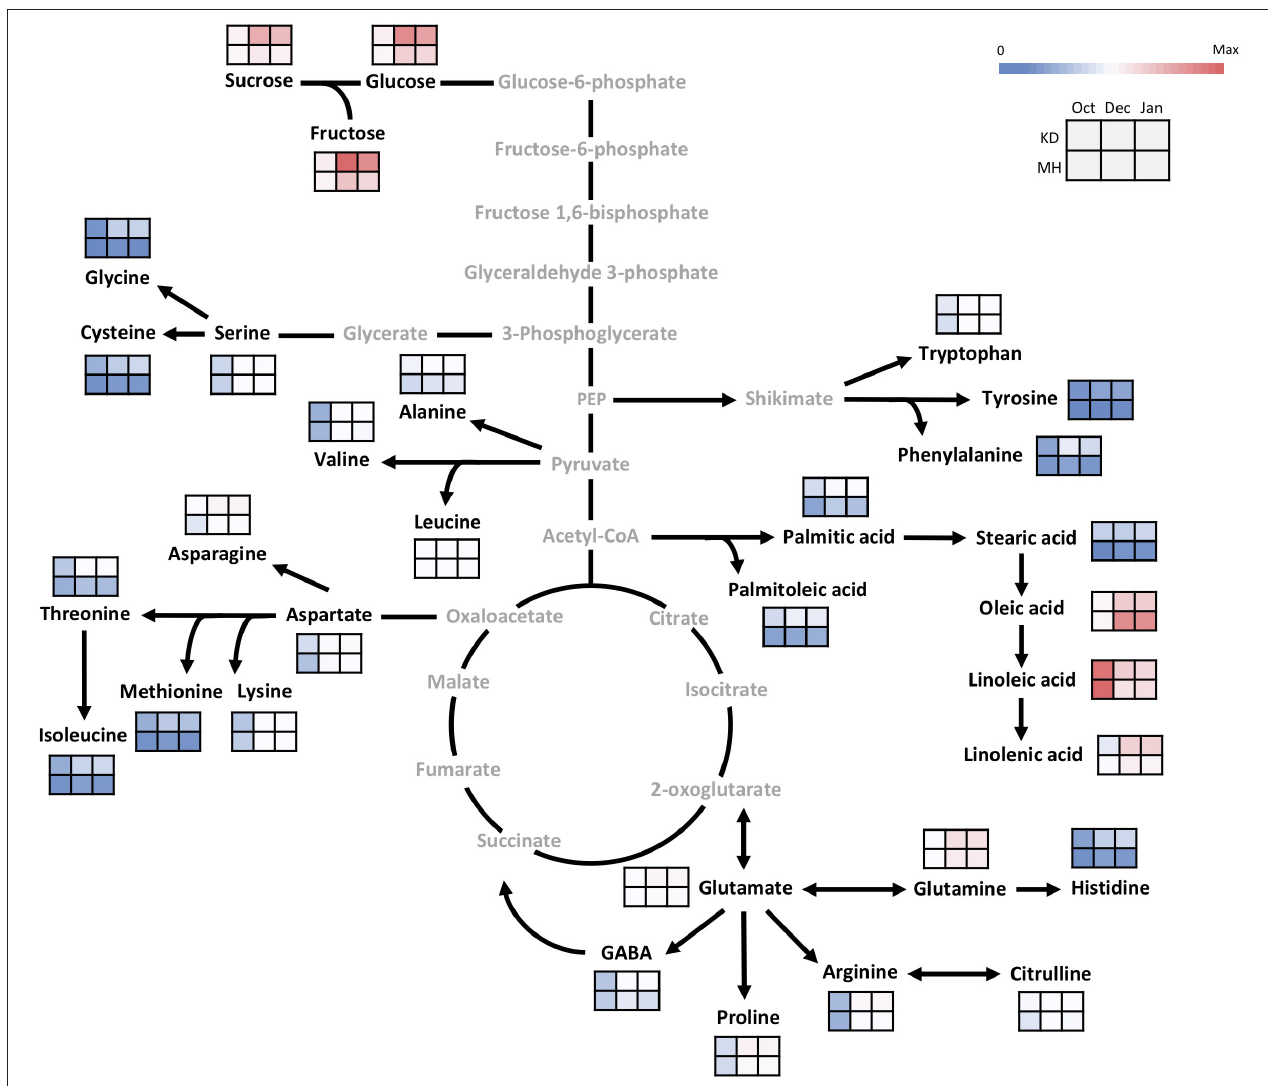
FIGURE 6 | Changes in the primary metabolism in the bud of KD and MH during the hardening process from October to January. Quantified metabolites are set in black and non-measured metabolites are set in gray color. Each heat map represents the intensity of the corresponding metabolite at three time-points (October, December, and January) of hardy (KD) and sensitive (MH) genotypes; October (control or pre-hardening stage), December, and January (hardening